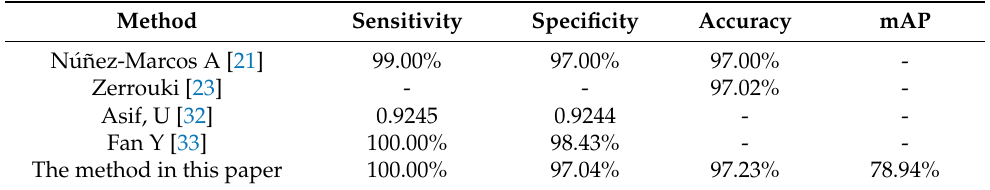
Table 4. Comparison of the proposed fall detection method with other state-of-the-art fall detection methods on Le2i.